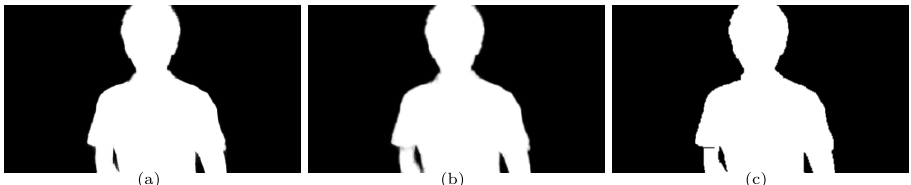
Fig. 11 (a) Matting result without sampling acceleration. (b) Matting result with sampling acceleration. (c) Foreground segmentation result with sampling acceleration but without alpha matting border refinement. substitution method for live video. It optimizes